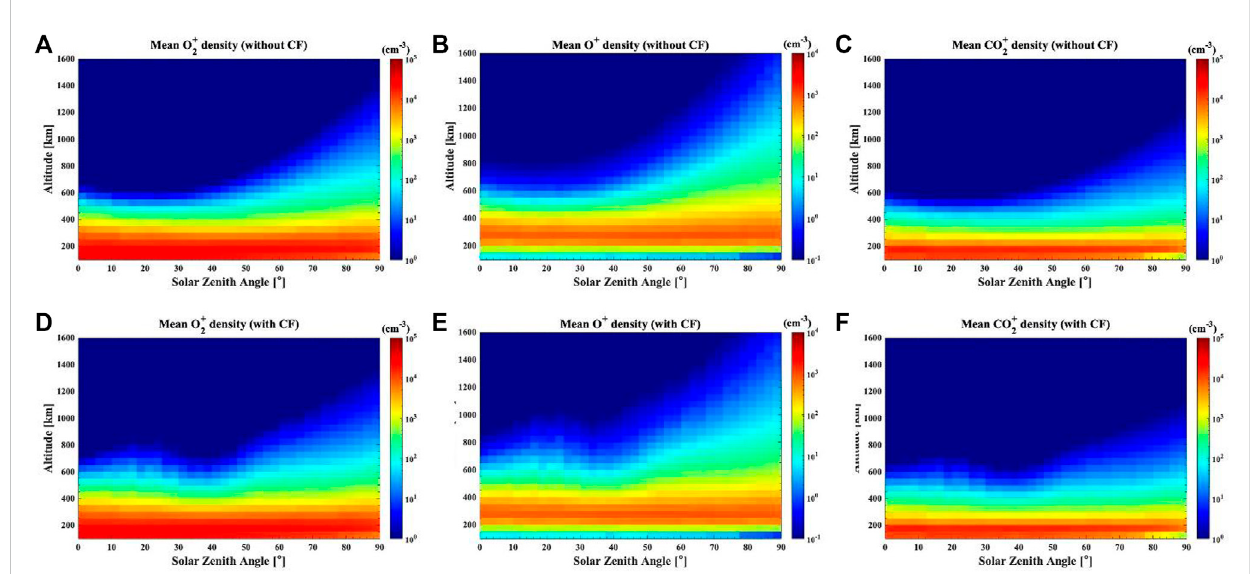
FIGURE 4 Thedistributionsofthelogarithmicnumberdensity ofO 2 + (A,D) ,O + (B,E) ,andCO 2 + (c.f)intheSZA-Altitudecoordinatesystem,inthecasewithout (A – C) and with (D – F) crustal fi elds.